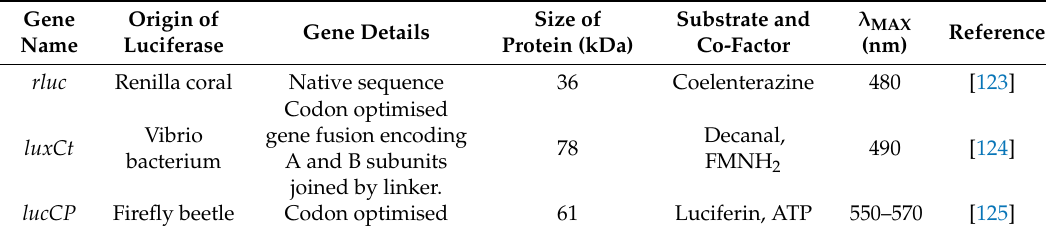
Table 2. Luciferase genes developed as reporters for the C. reinhardtii